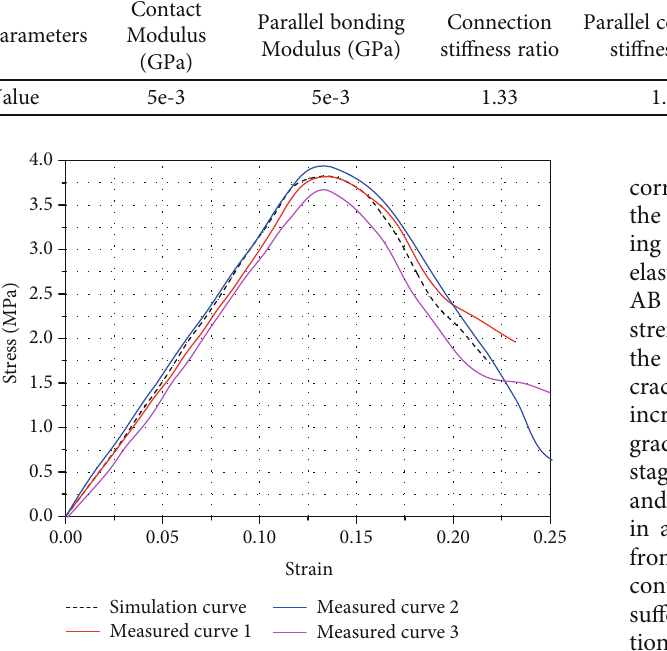
Figure 2: Comparison of laboratory loading test results and simulation